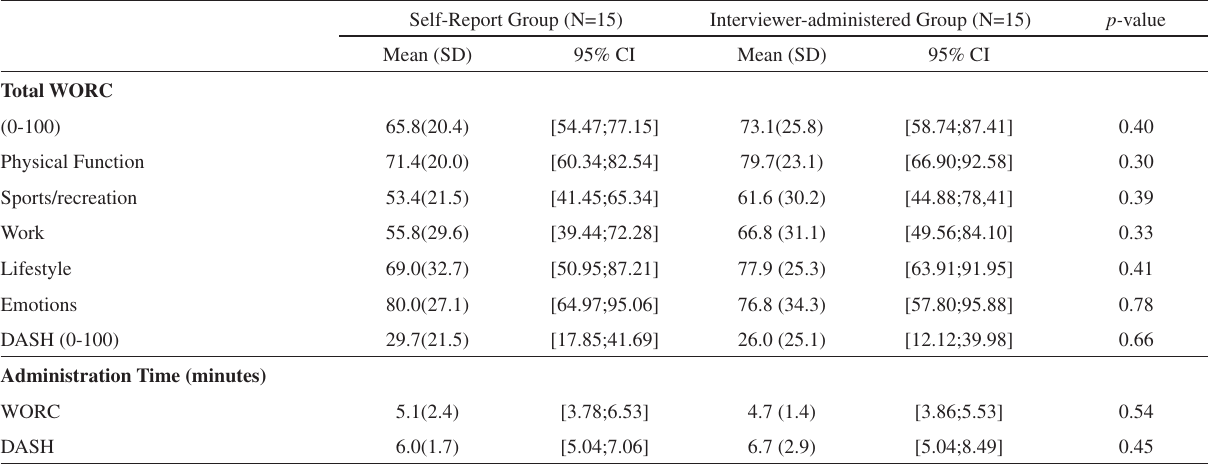
Table 2 - Scores for the questionnaires and administration time in each